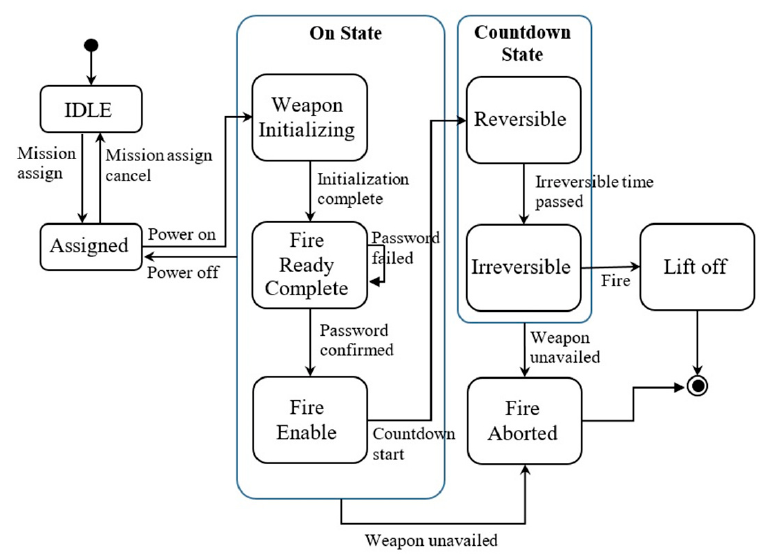
Figure 9. FSM of the army missile console software.